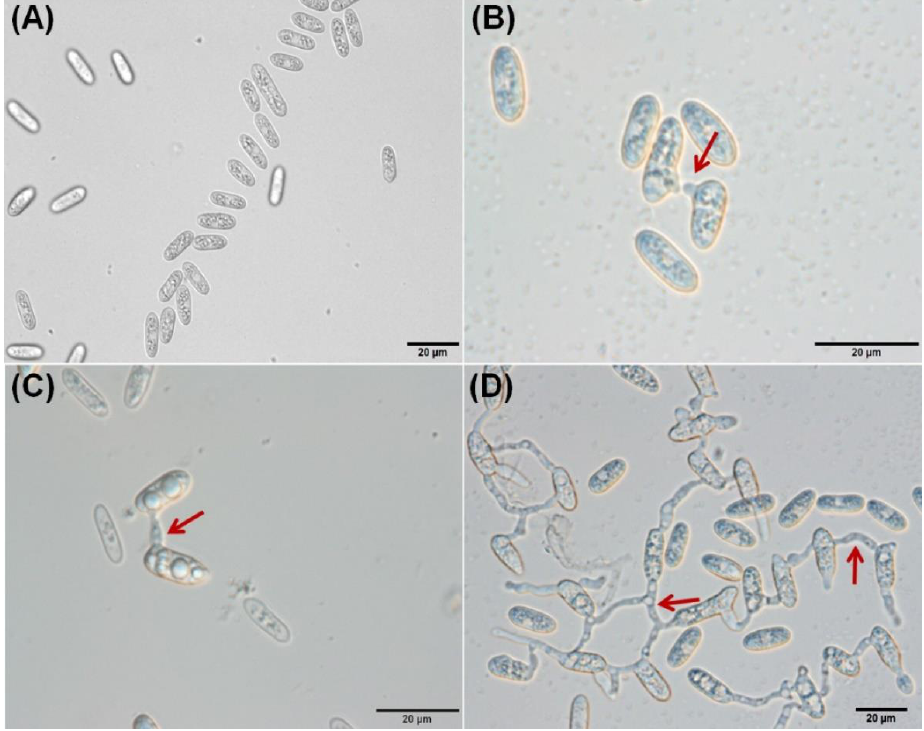
Figure 1. Different stages of CAT fusion in C. gloeosporioides in vitro. ( A ) CAT induction. ( B ) CAT homing. ( C ) CAT fusion. ( D ) CAT network. Arrow indicates CAT fusion. Scale Bar = 20 μm.